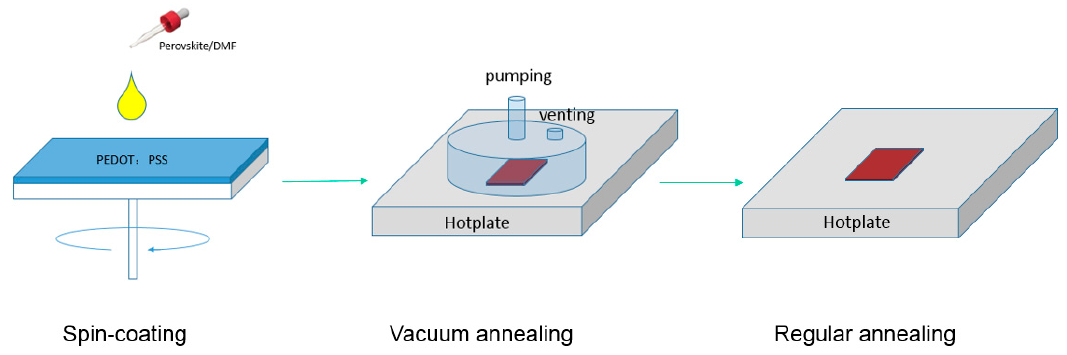
Figure 2. Schematic of the vacuum assisted one ‐ step solution (VAOS) preparation method of the perovskite film.